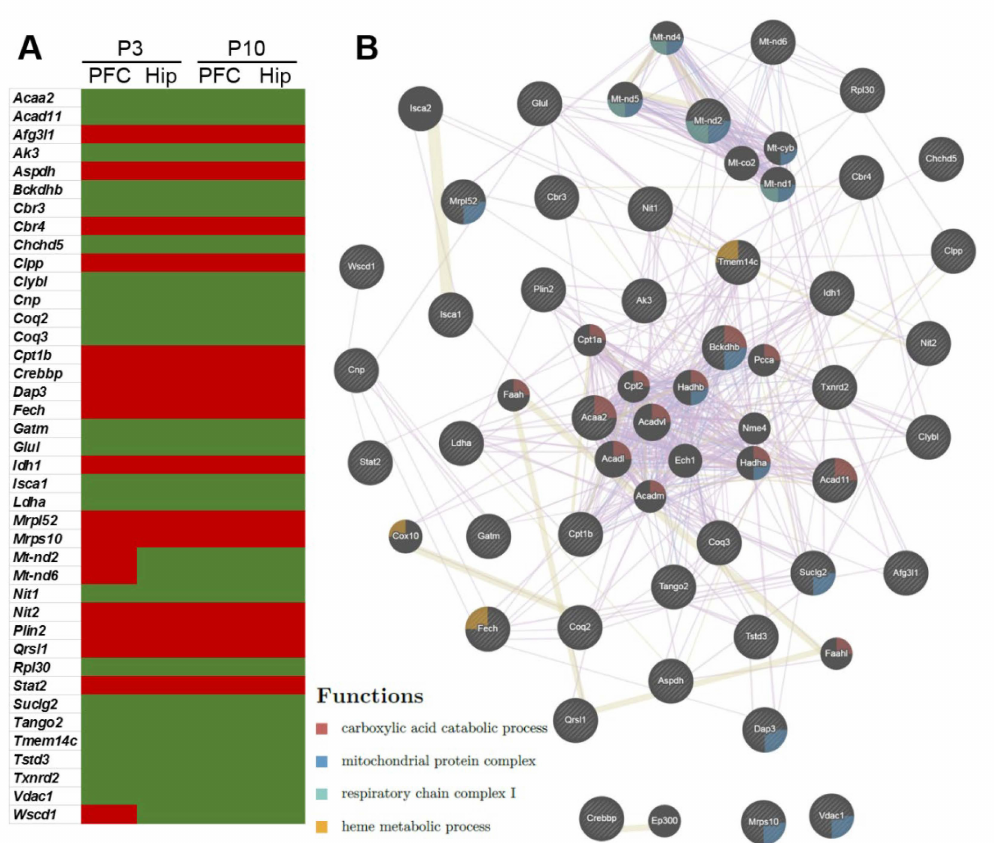
Figure 4. Changes in expression of matching genes related to mitochondrial function in the PFC and hippocampus of 3- and 10-day-old OXYS rats compared to age-matched Wistar rats. ( A ) Up- and downregulated matching DEGs in OXYS rats. ( B ) GO terms that (according to GeneMania) are enriched within the set of 40 DEGs that matched among the two age periods and two brain